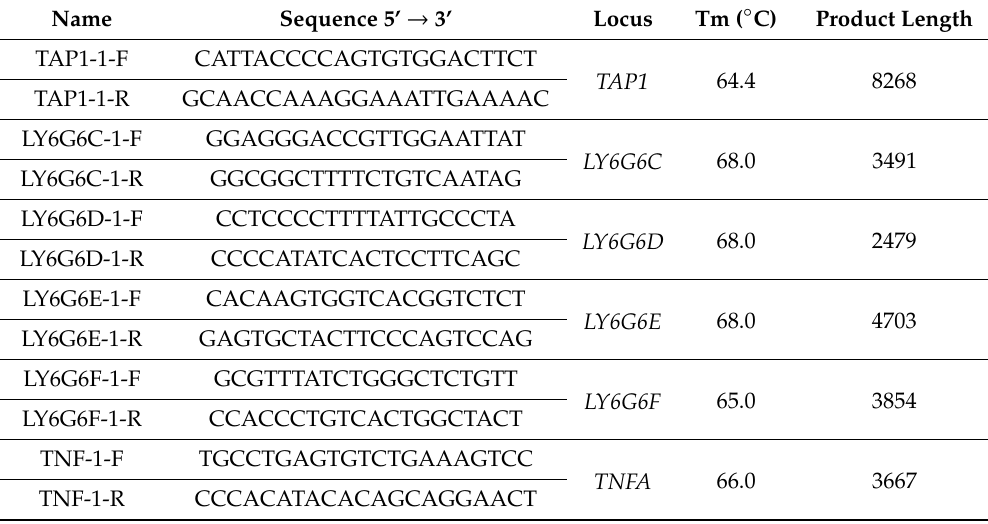
Table 2. List of primers used in amplification of selected major histocompatibility complex (MHC) genes in